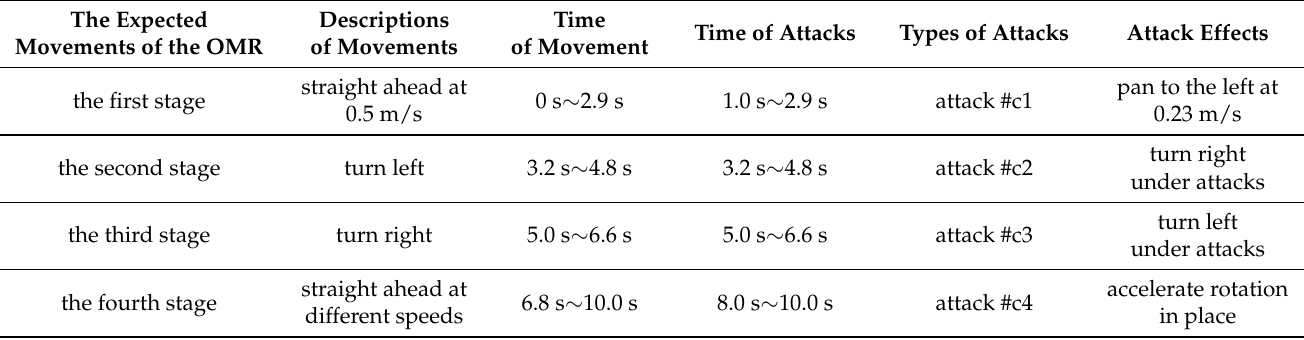
Table 1. The expected movement of the OMR and the corresponding covert attacks.